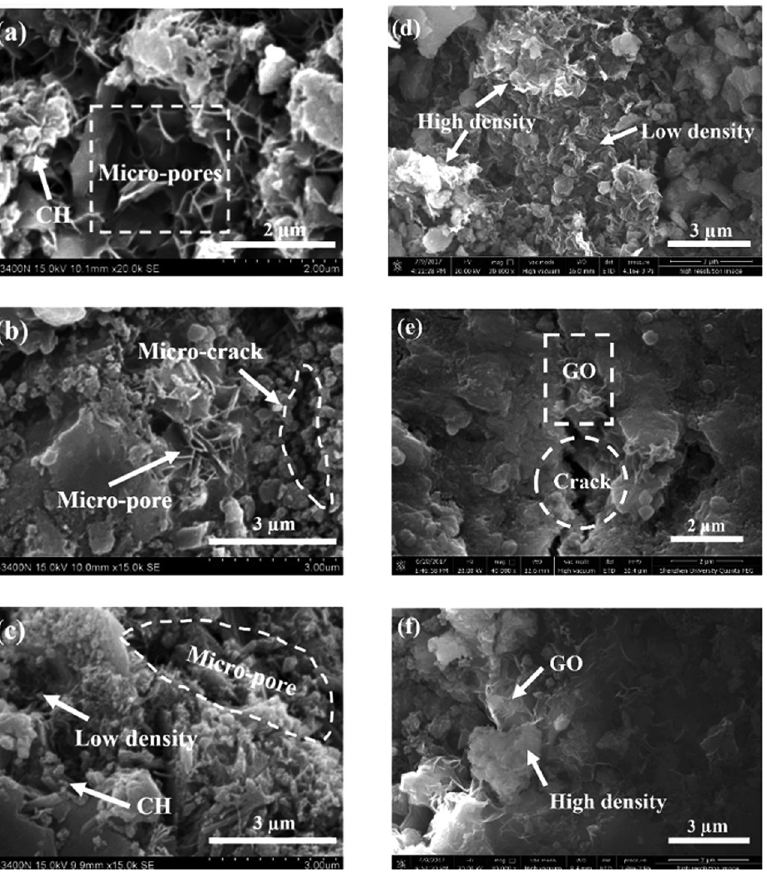
Figure 5: SEM images of crystal morphology at di ff erent magni fi cations in plain - cement paste ( a – c ) and in GO - cement paste ( d – f ) after 7 days of curing [ 79 ]